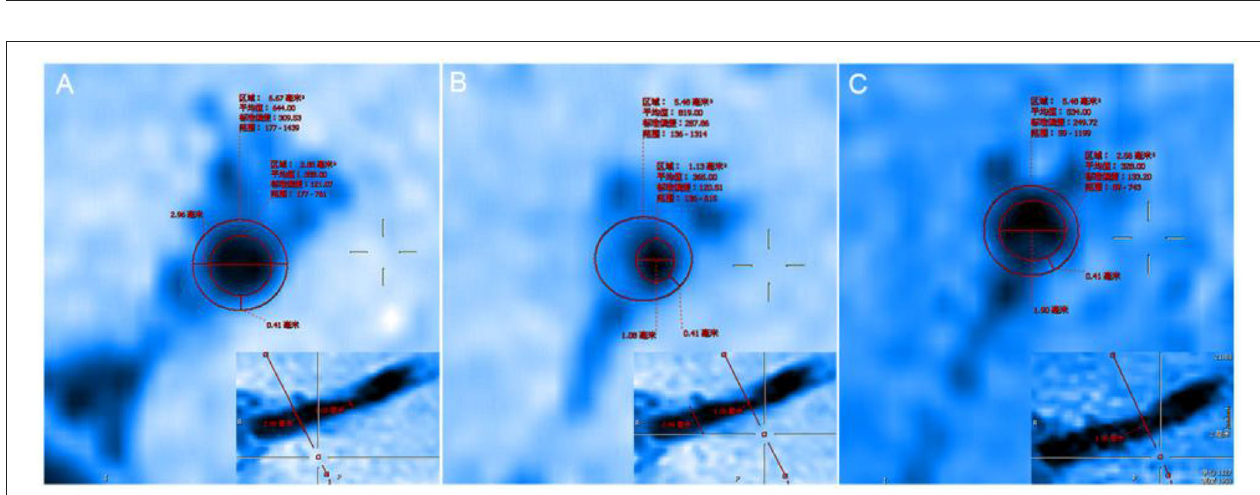
FIGURE 4 | (A) The proximal vessels serve as the reference site. (B) The maximal-lumen-narrowing site before follow-up. (C) The maximal-lumen-narrowing site after